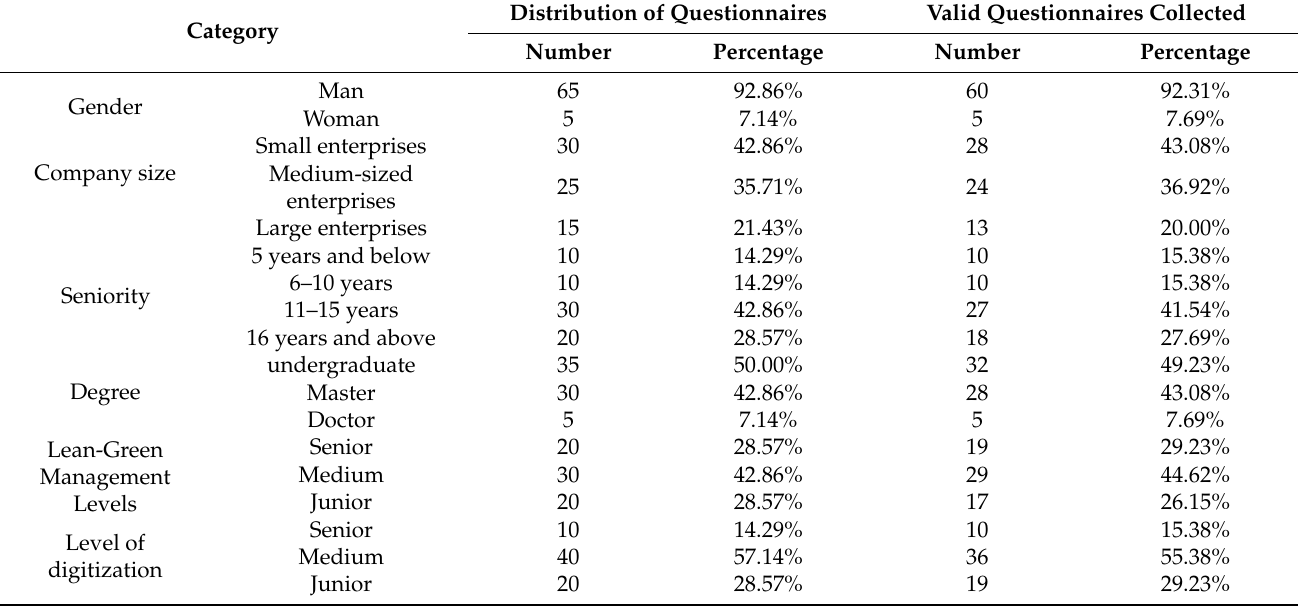
Table 4. Distribution of experts participating in the questionnaire.